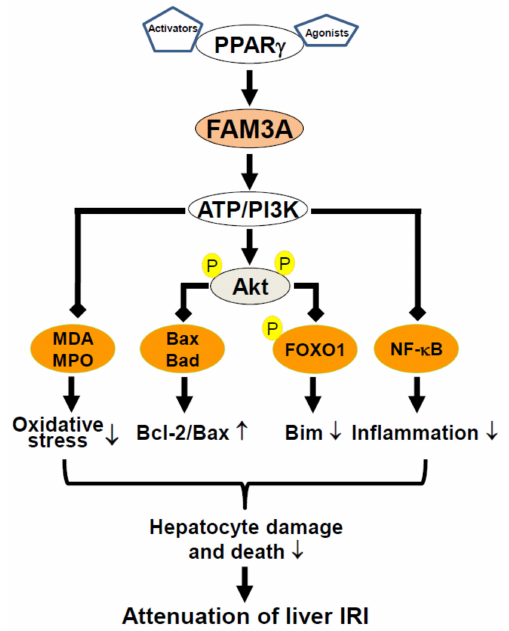
Figure 2. Proposed protective mechanisms of PPAR γ - FAM3A axis in liver IRI. FAM3A exerts beneficial effects on liver IRI via the activation of ATP-PI3K-Akt pathways, inhibition of inflammation, and attenuation of oxidative stress. As a direct target gene of PPAR γ , FAM3A mediates the protective effects of PPAR γ activation on liver IRI. IRI, ischemia/reperfusion injury. MDA, methane dicarboxylic aldehyde; MPO,